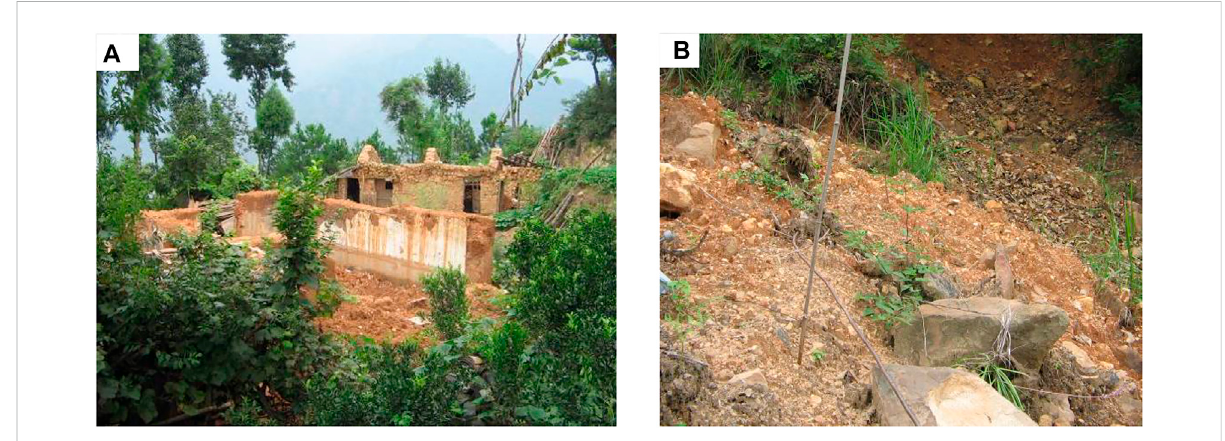
FIGURE 3 The Three Gorges Reservoir was impounded to 156 m for the fi rst time in 2007, resulting in (A) damage to a house caused by cracks in the rear edge of the landslide, (B) small-scale slump in the middle of the landslide.